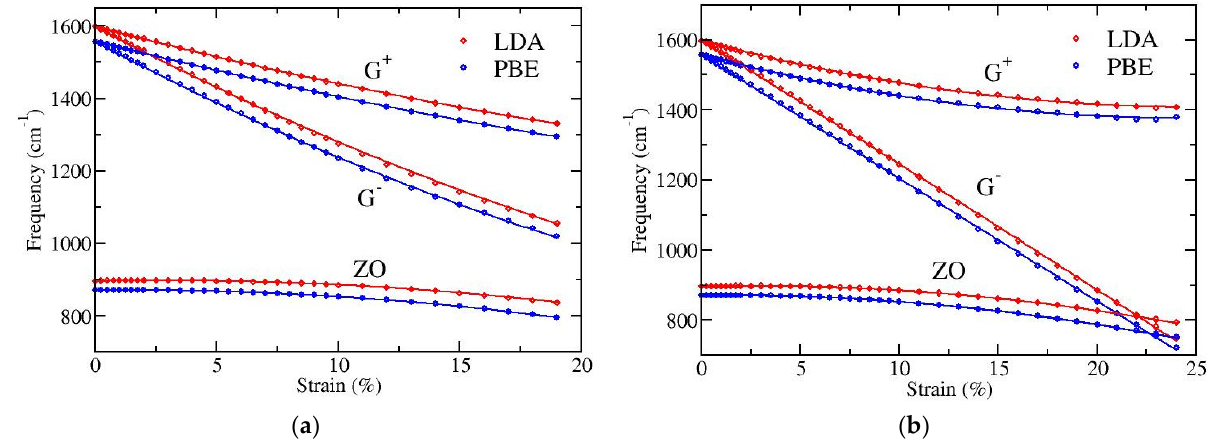
Figure 4. Strain dependence of the in-plane optical phonons (G band), that splits into G + and G – bands, and of the out-of-plane optical mode ZO for strain in the ( a ) armchair and ( b ) zig-zag directions, as obtained by DFT calculations at the level of LDA/PZ (red) and GGA/PBE (blue) functionals.